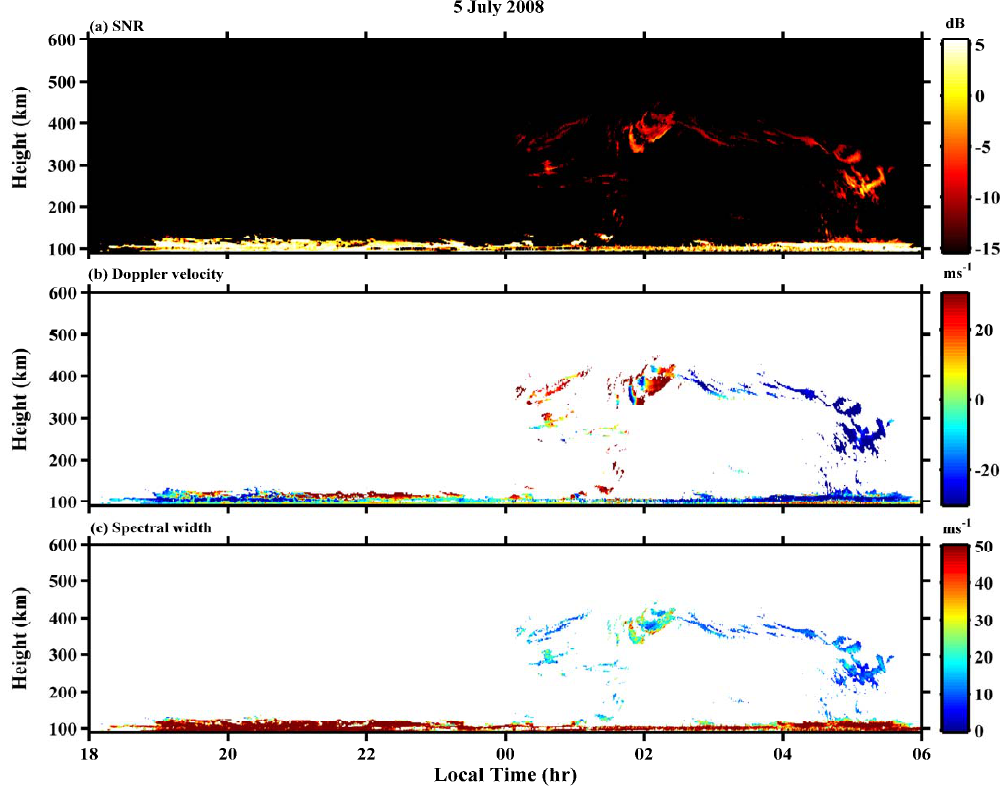
Fig. 3. Same as Fig. 1, but for 5 July 2008. Note that the scales are different from those in Fig.